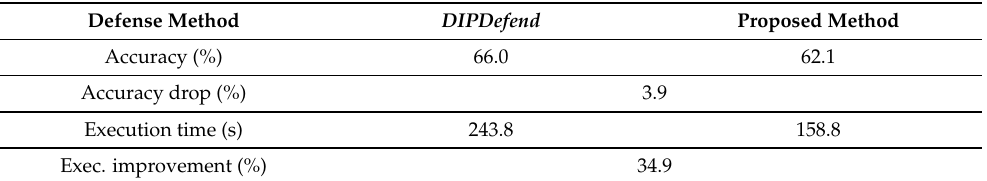
Table 16. Comparison between DIPDefend and the proposed method with original (unattacked)